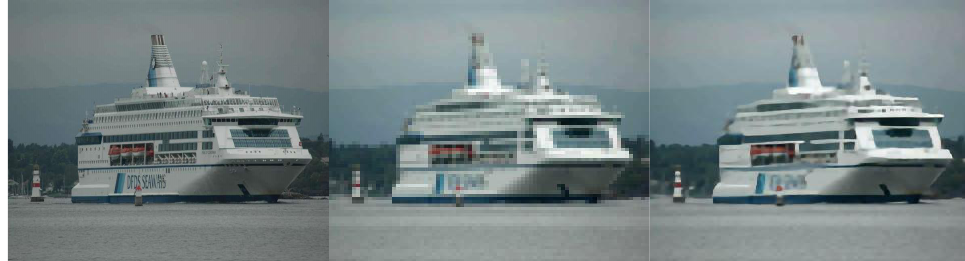
Figure 7. Comparison of different image